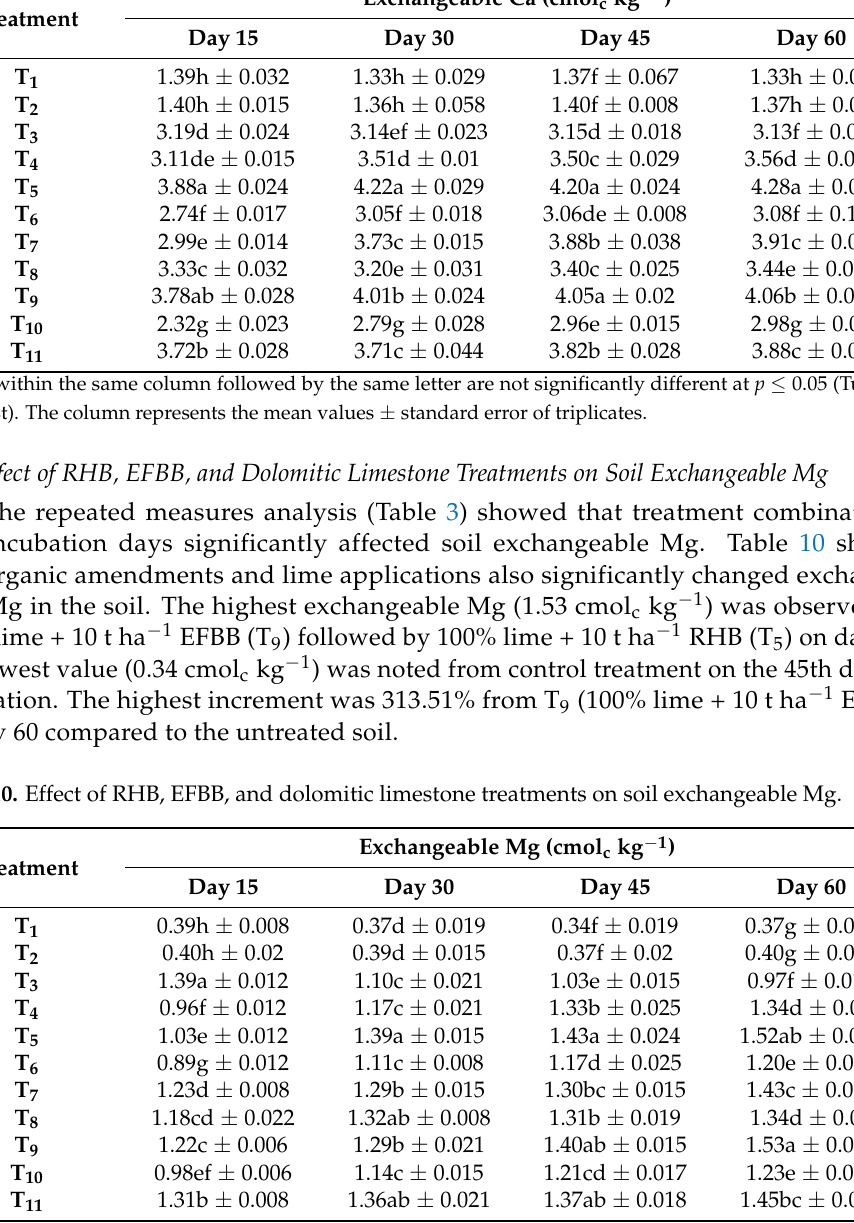
Table 9. Effect of RHB, EFBB and dolomitic limestone treatments on soil exchangeable Ca. Treatment